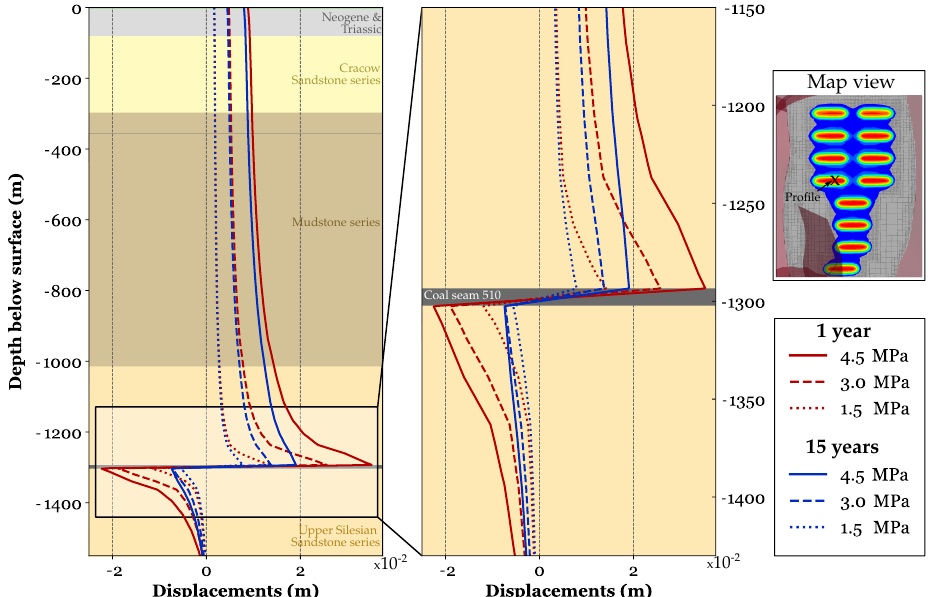
Figure 7. Vertical profile from the model top through one of the horizontal injection panels of coal seam 510 exhibiting the simulated vertical displacements for constant injection pressures of 4.5 MPa,